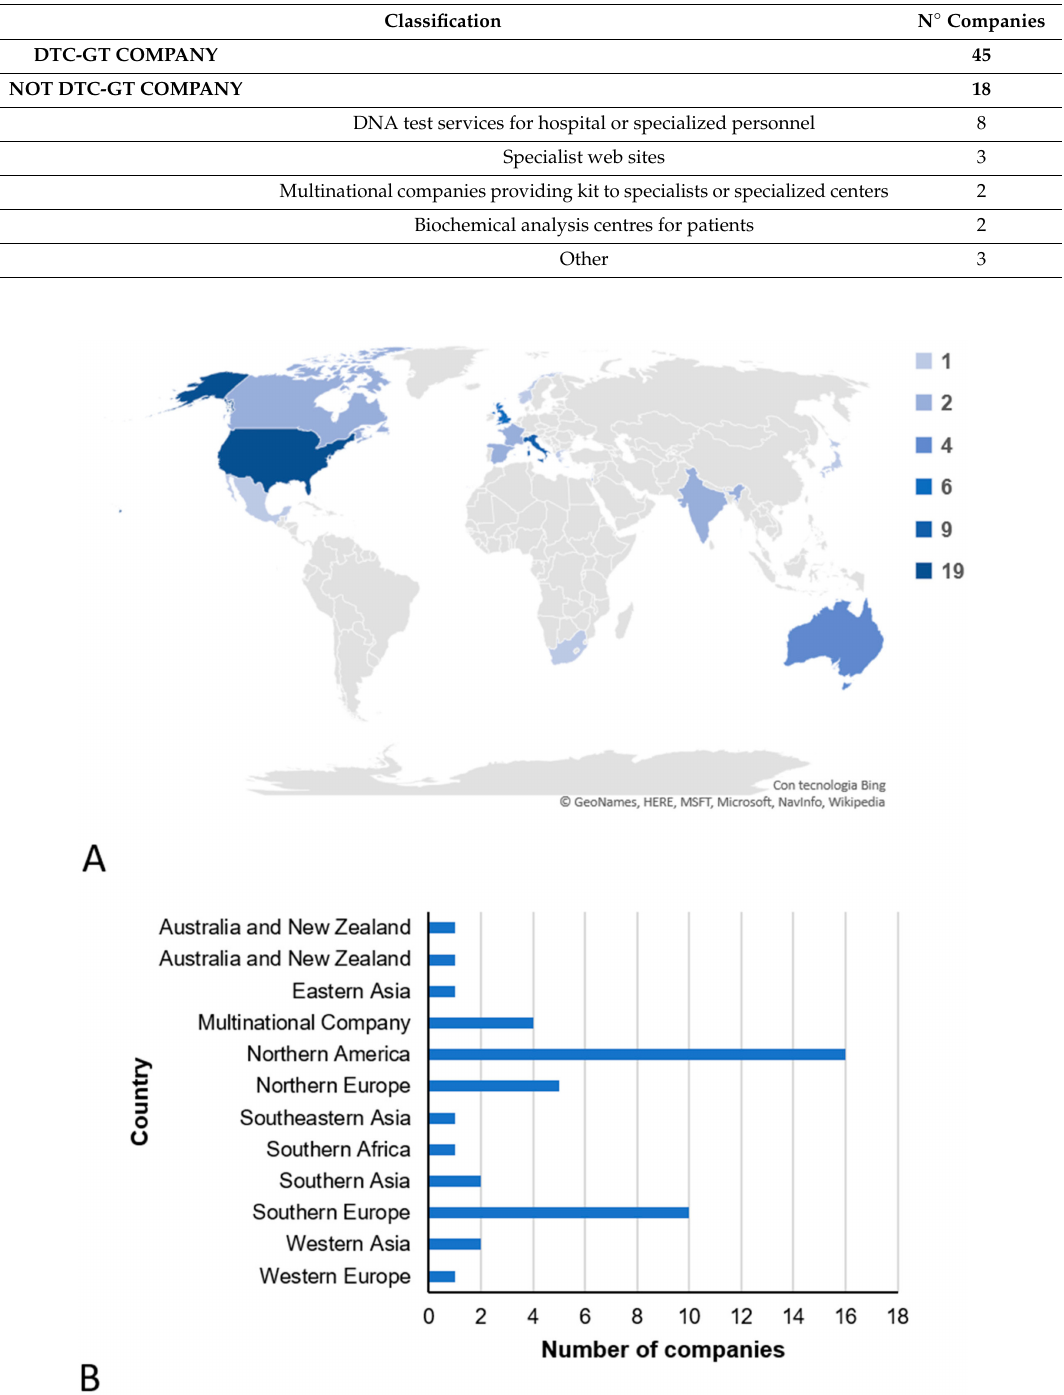
Table 1. Classification of the online company services. Direct-to-Consumer Genetic Testing (DTG-GT);